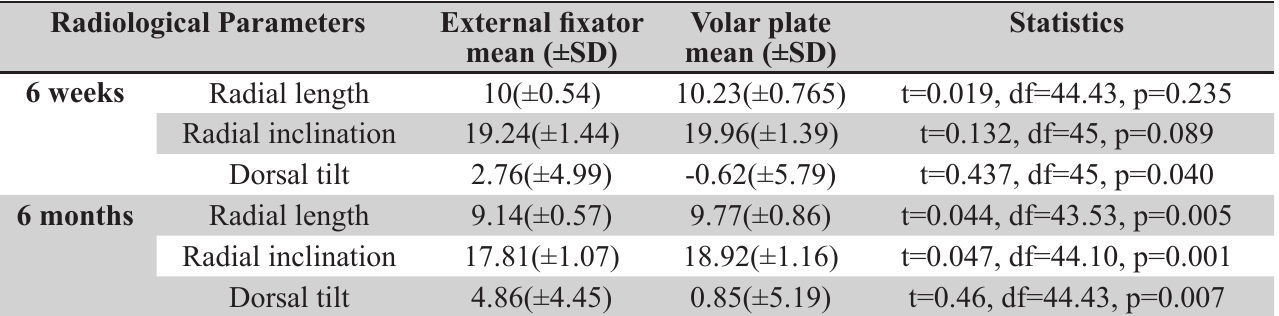
Table 3. Radiological results at 6 weeks and 6 months. Radiological